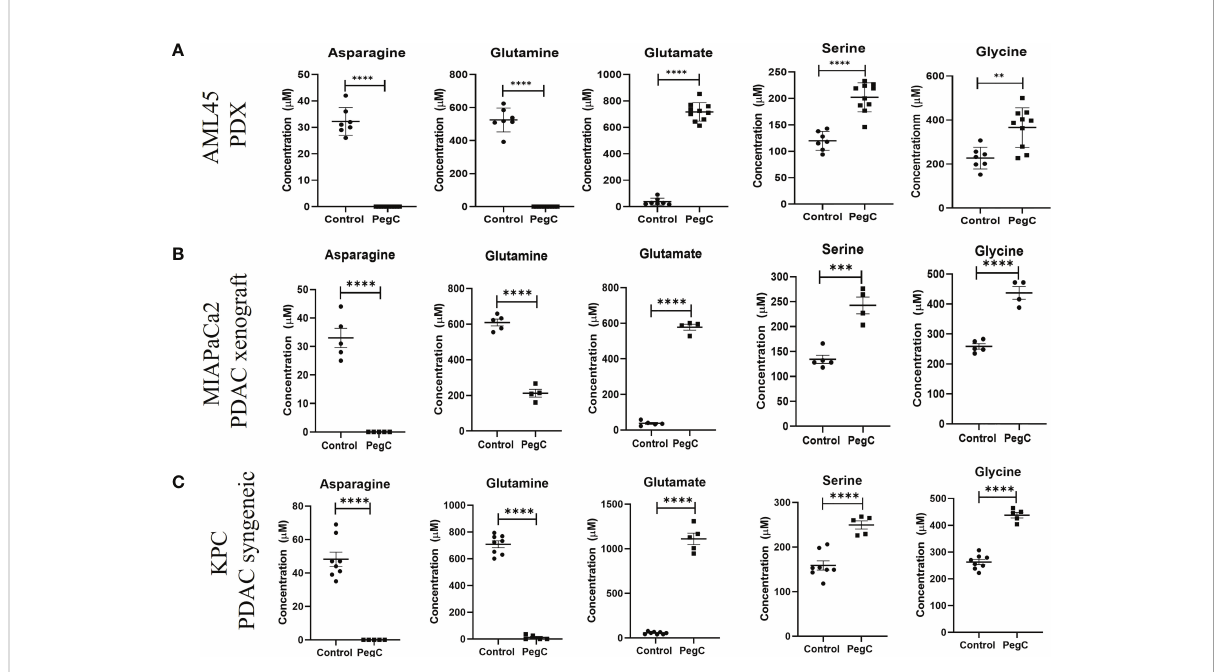
FIGURE 2 PegC increases serine and glycine in AML PDX and PDAC xenograft/syngeneic models. (A) Plasma was isolated from whole blood of AML- bearing NRG mice that did (n=10) or did not (n=7) receive PegC (200 IU/kg, IV, 1x/week) for 4 weeks. HPLC was performed to measure the concentration of the indicated amino acids. (B) Plasma was isolated from whole blood of MIAPaCa2 xenograft-bearing NRG mice that did (n=4) or did not (n=5) receive PegC (200IU/kg, IV, 1x/week). HPLC was performed to measure the concentration of the indicated amino acids. (C) Plasma was isolated from whole blood of KPC tumor-bearing C57BL/6 mice that did (n=5) or did not (n=8) receive PegC (500 IU/kg, IV, 1x/ week). HPLC was performed to measure the concentration of the indicated amino acids. Statistical analyses to compare vehicle and PegC treated groups were performed using unpaired t- tests. **** p < 0.0001, *** p < 0.001, ** p <